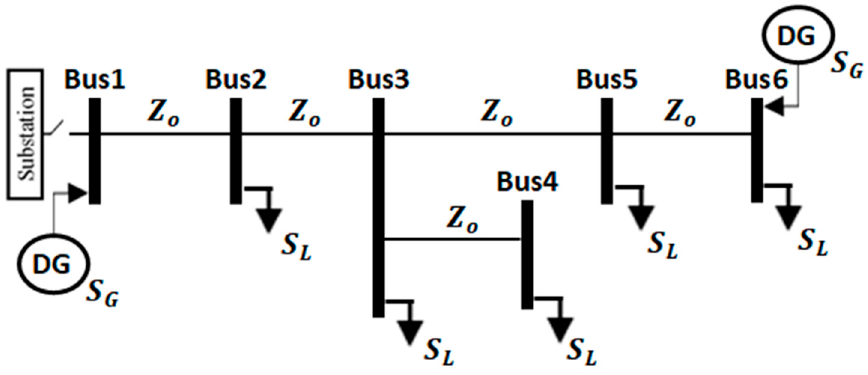
Figure 8. Six-bus microgrid.